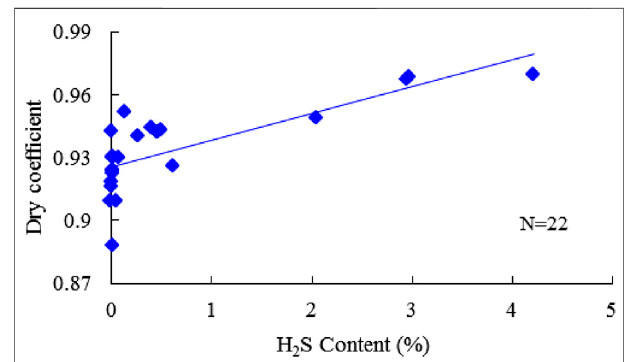
FIGURE 7 | Relationship between dry coef fi cient and H 2 S content.